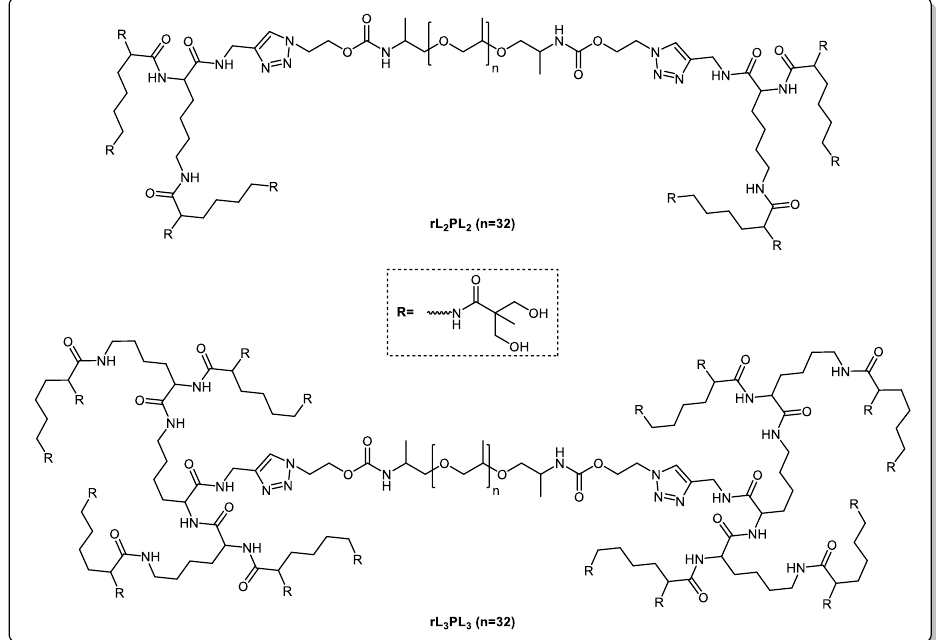
Figure 6. The chemical structure of rL 2 PL 2 & rL 3 PL 3 (n = 45) triblock